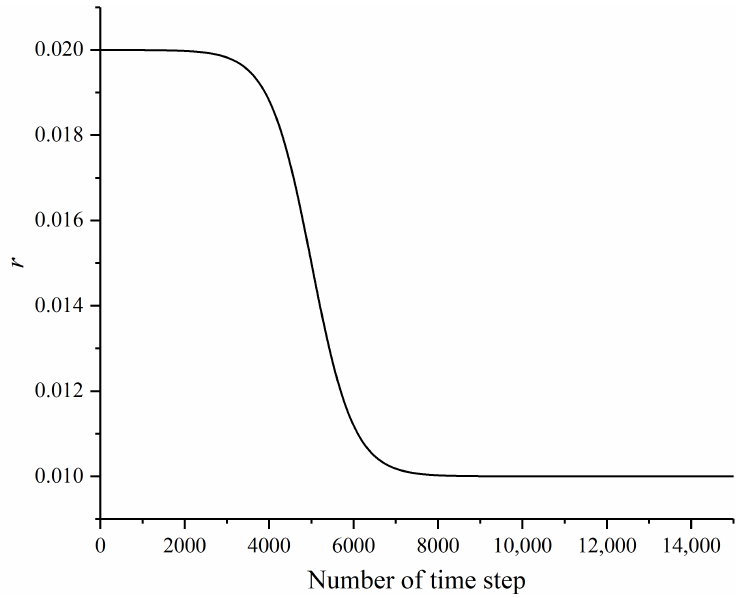
Figure 2. Trend of the coefficient r with the training time